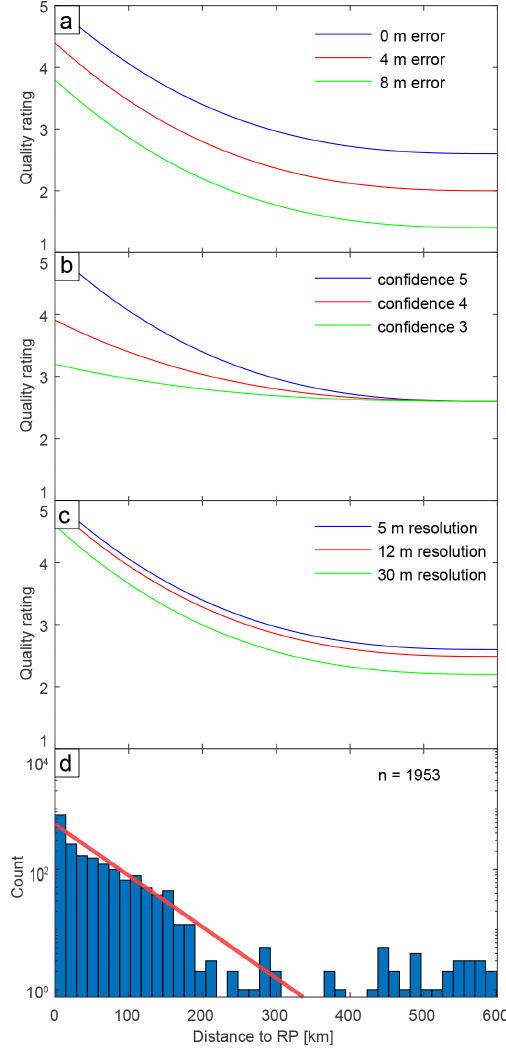
Figure 4. Influence of the parameters on the quality rating. The x axis is the distance to reference point (RP), the y axis is the qual- ity rating, and the color lines represent different values of quality- rating parameters. While one parameter is being tested, the remain- ing parameters are set to their best values. That is why the QR does not reach values of 1 in the graphs displayed here. (a) Shoreline- angle elevation error. (b) Confidence value of the referencing point. (c) Topographic resolution of the DEM used for terrace-elevation estimation. (d) Histogram displaying the distribution of distances between each shoreline-angle measurement and its nearest RP ( n : number of measurements). The red line is an exponential